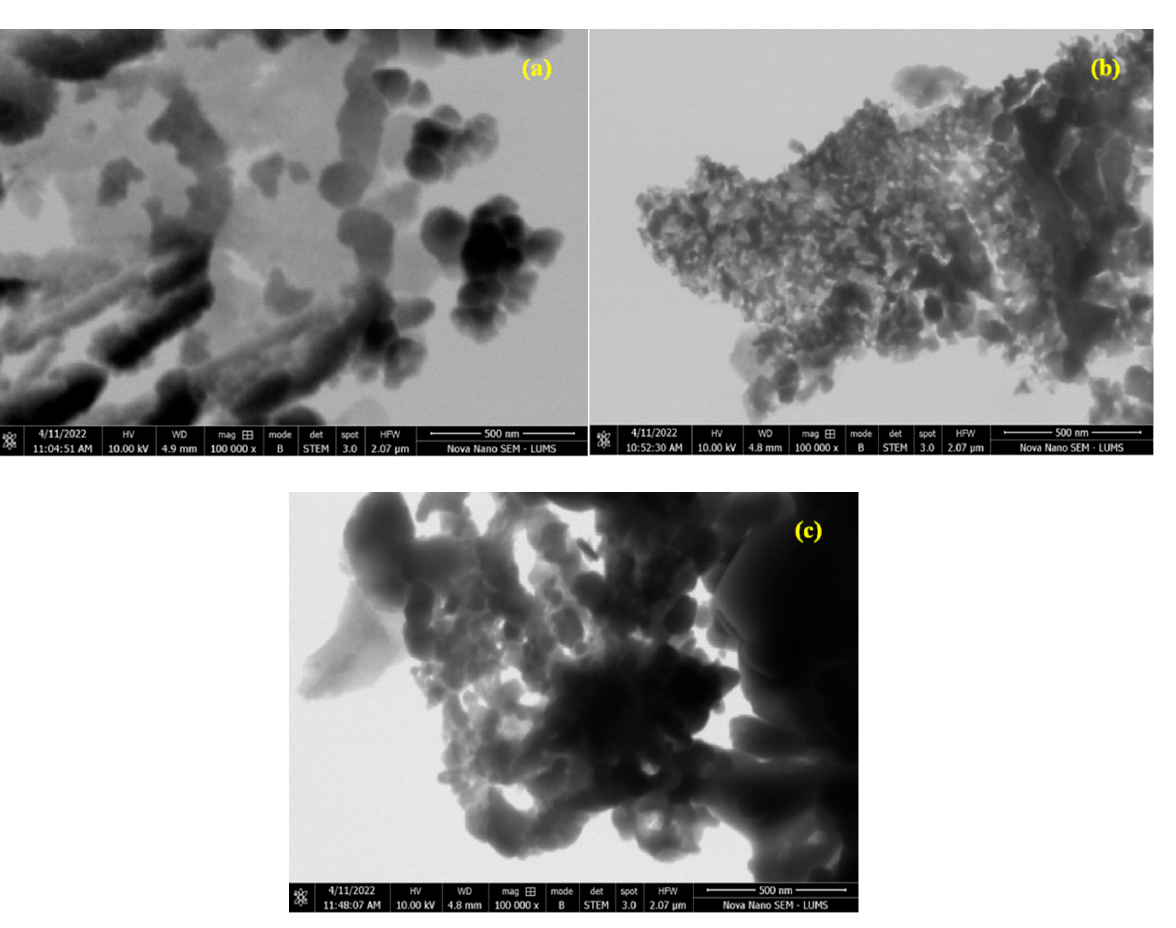
Figure 7. STEM images of ( a ) Cr 0.20 ZnS, ( b ) Cr 0.25 ZnS, and ( c ) Cr 0.30 ZnS catalyst samples. The statistical distribution of Cr x ZnS (x = 0.20, 0.25, and 0.30) is expressed within the range of 1–10 nm [28]. Figure 8 shows the distribution of particle sizes measured from the STEM images. The average particle size of Cr 0.20 ZnS, Cr 0.25 ZnS, and Cr 0.30 ZnS was measured at about 82 nm, 79 nm, and 76 nm,